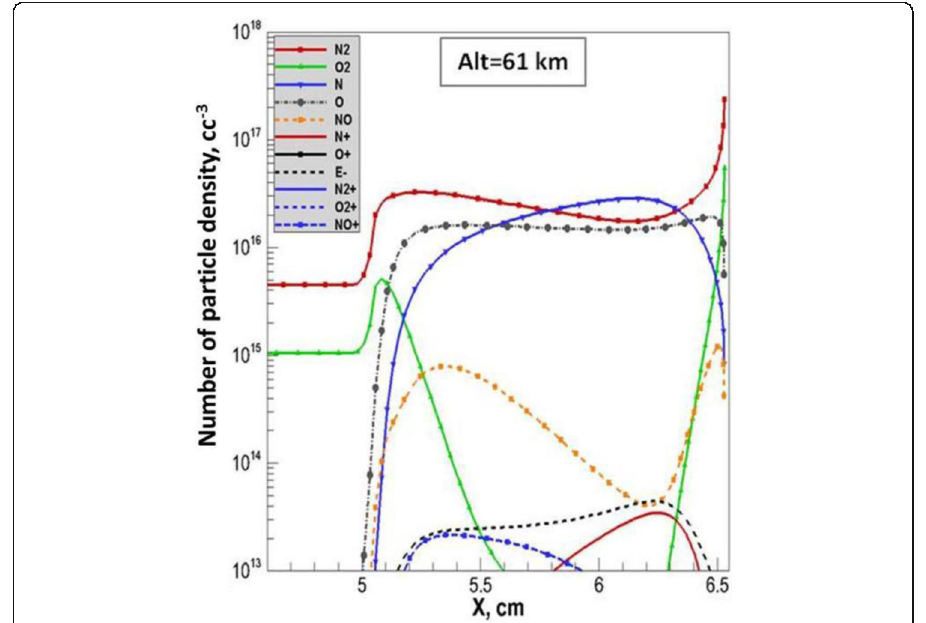
Fig. 13 Species concentration along stagnation streamline of RAM-C-II